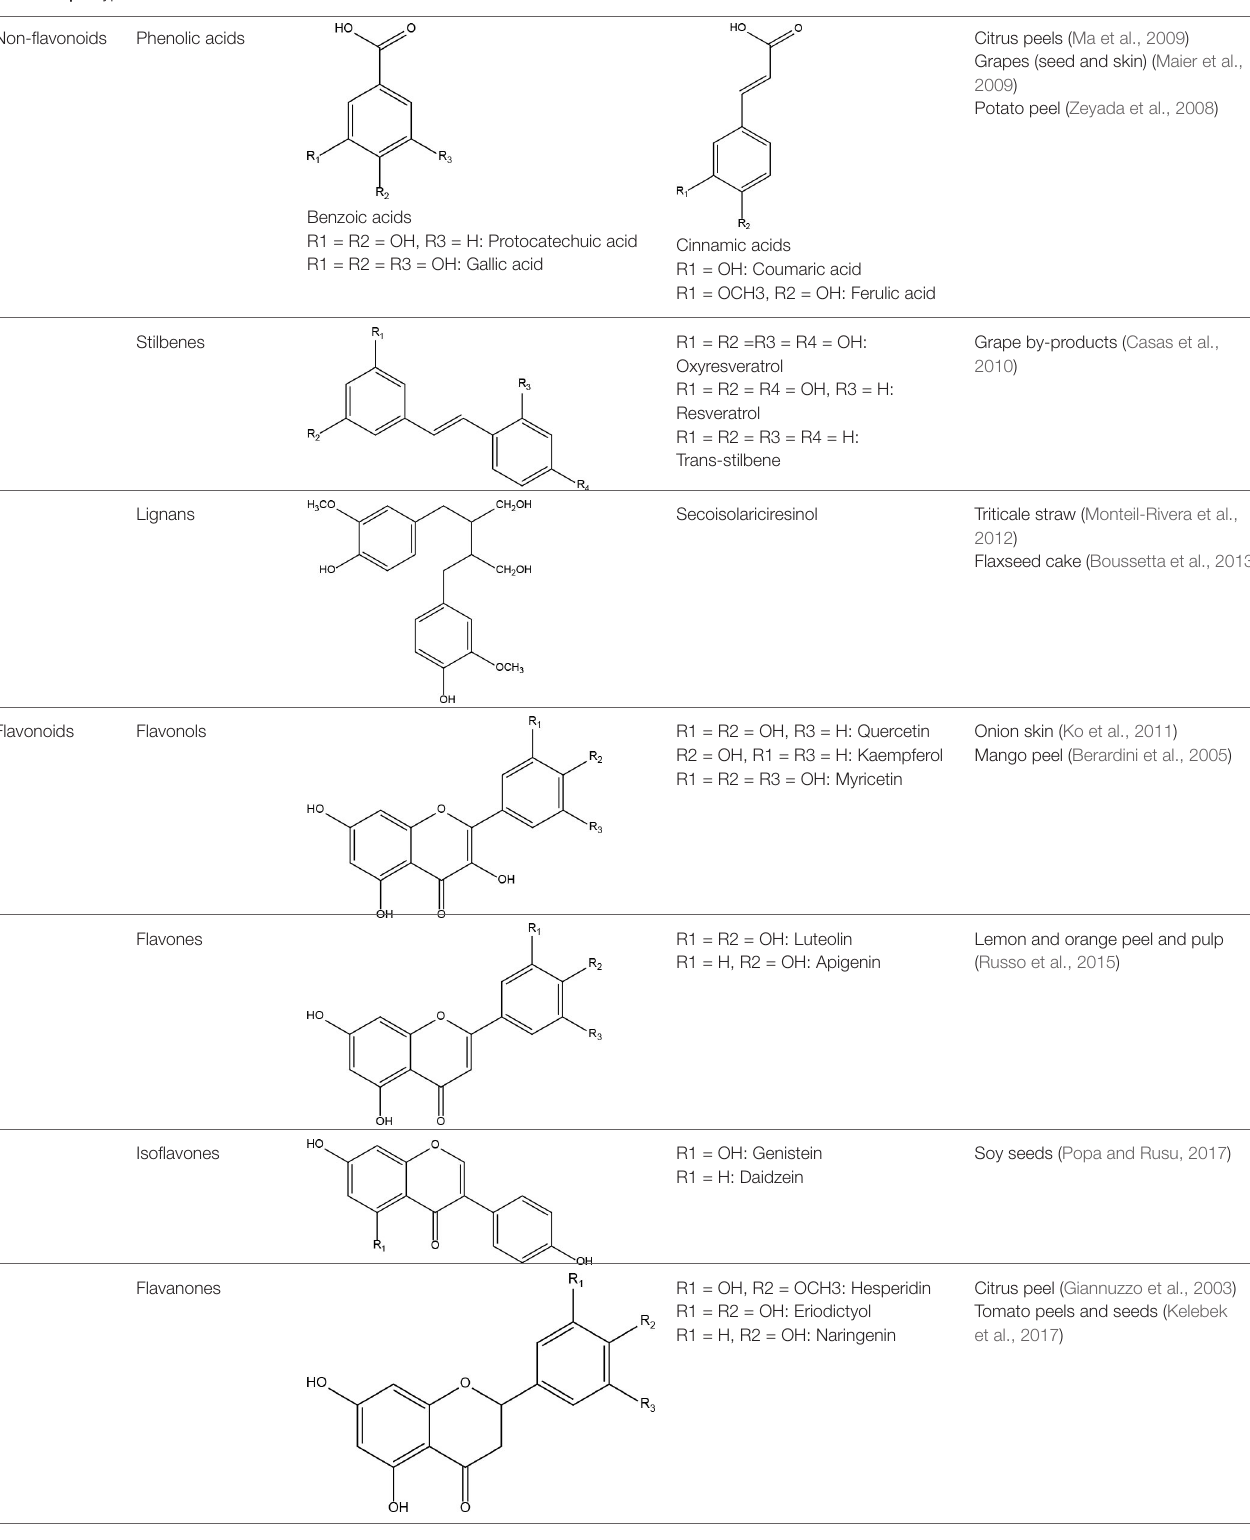
TABLE 1 | Polyphenols classification.